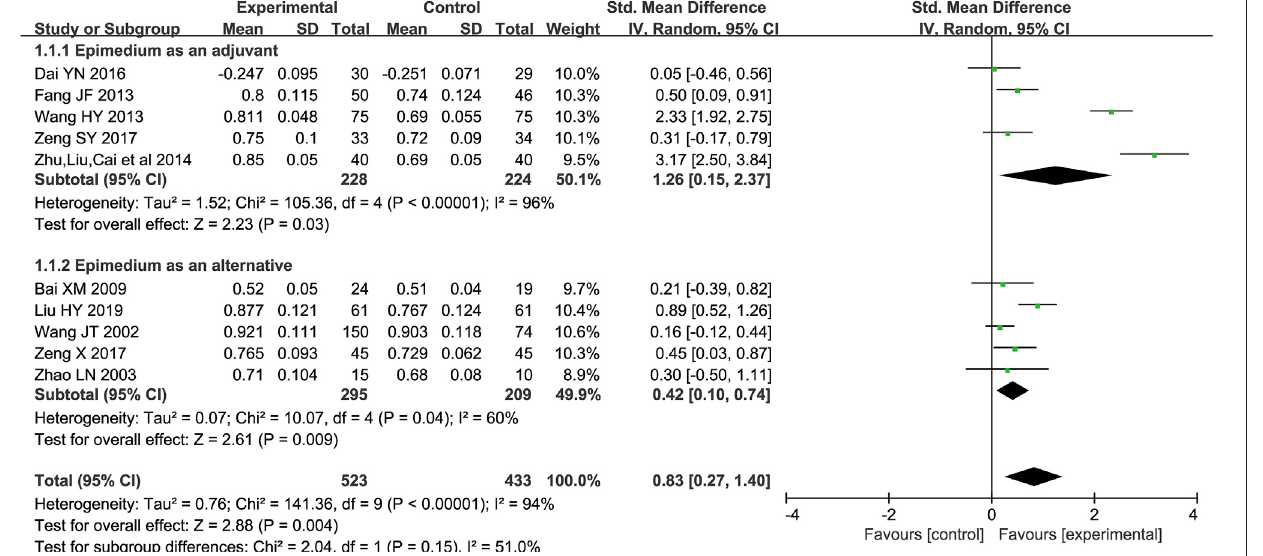
Frontiers in Pharmacology |